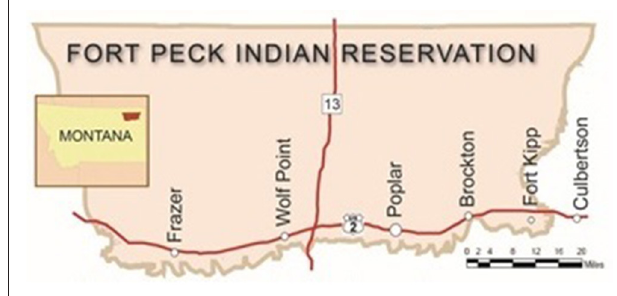
FIGURE 1 | Study sites on or near the fort peck